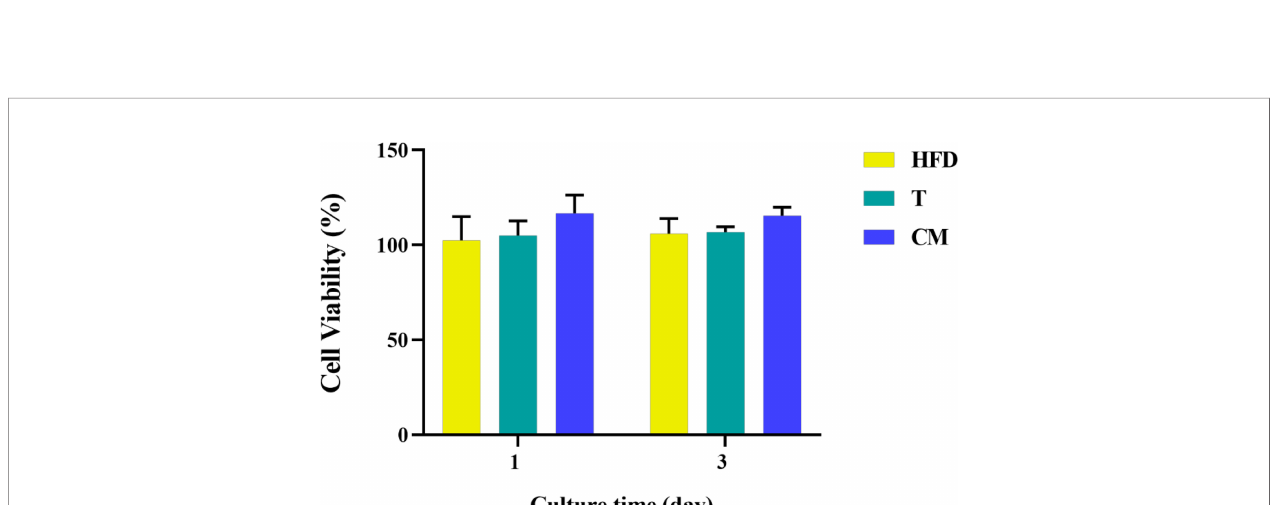
FIGURE 4 | Effect of HFD on the mouse primary T cells